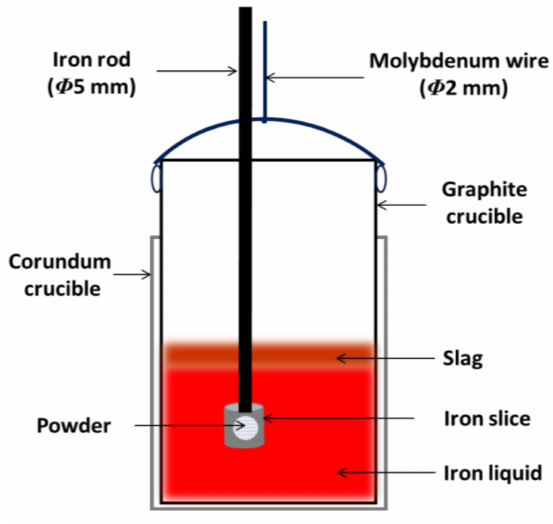
Figure 2. Diagram of crucibles and raw